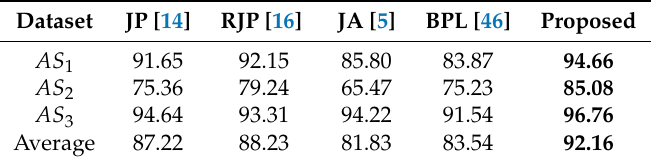
Table 1. Recognition performance on the MSR-Action3D for different feature spaces using the protocol of [8]. JP, joint position; RJP, relative position of the joint; JA, joint angle; BPL, body part location.